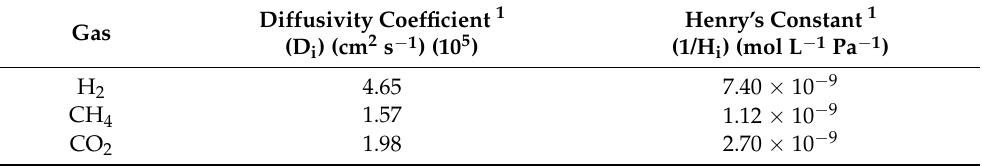
Table 2. Values of the Henry’s constant and of the diffusivity referred to all the gaseous